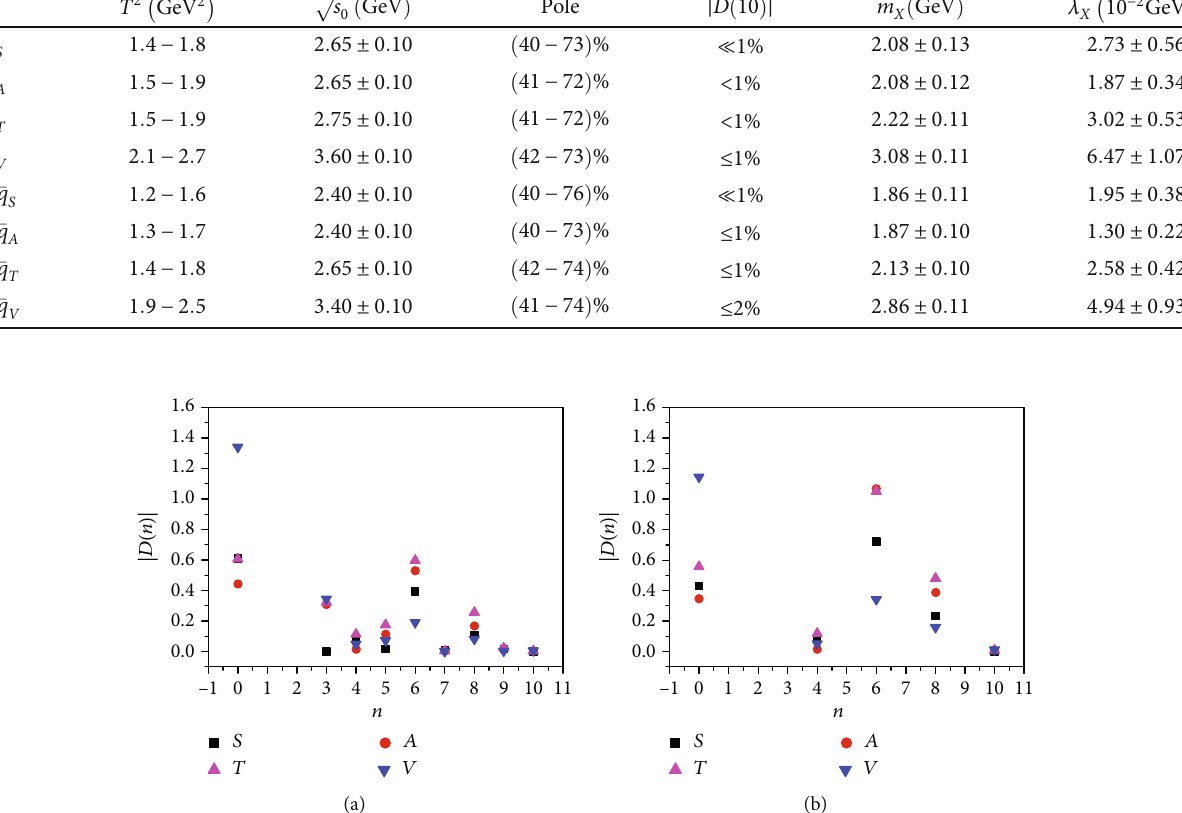
Figure 1: The absolute contributions of the vacuum condensates of dimension n for the central values of the input parameters in the operator product expansion, where the S , A , T , and V denote the scalar, axialvector, tensor, and vector tetraquark states, respectively, (a) and (b) denote the ss (cid:1) s (cid:1) s and qq (cid:1) q (cid:1) q quark constituents,